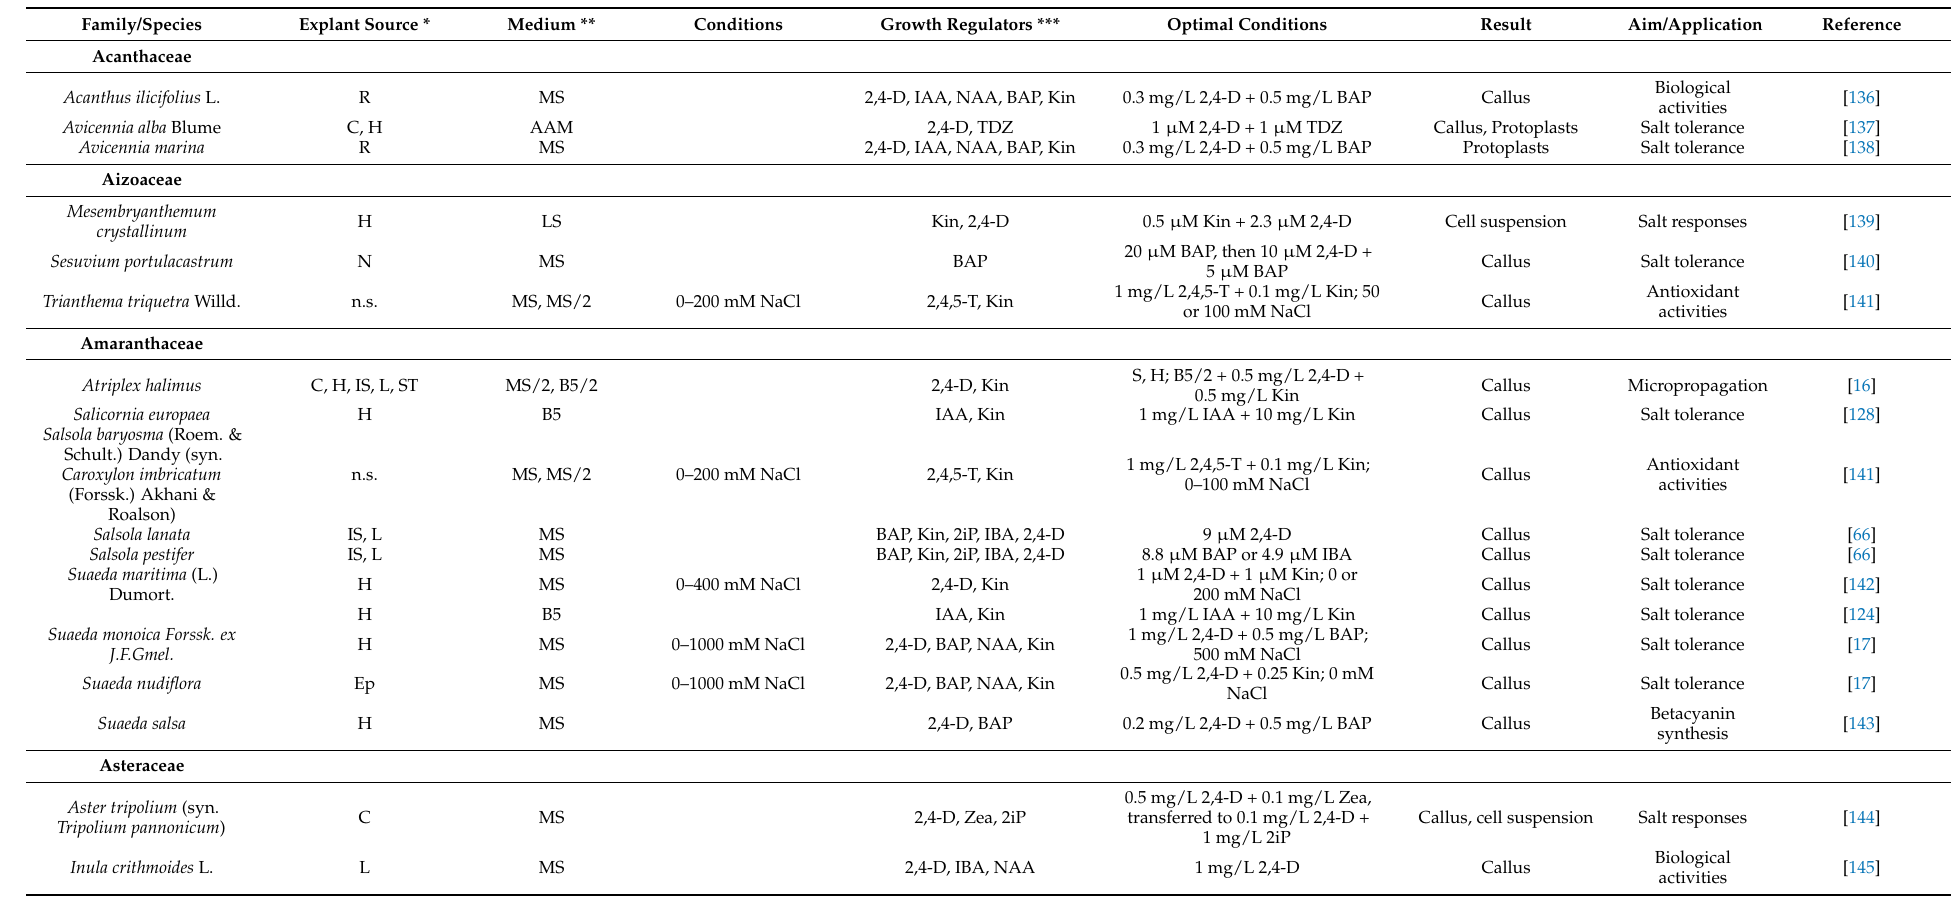
Table 2. Tissue and cell culture experiments reported in halophytes and their